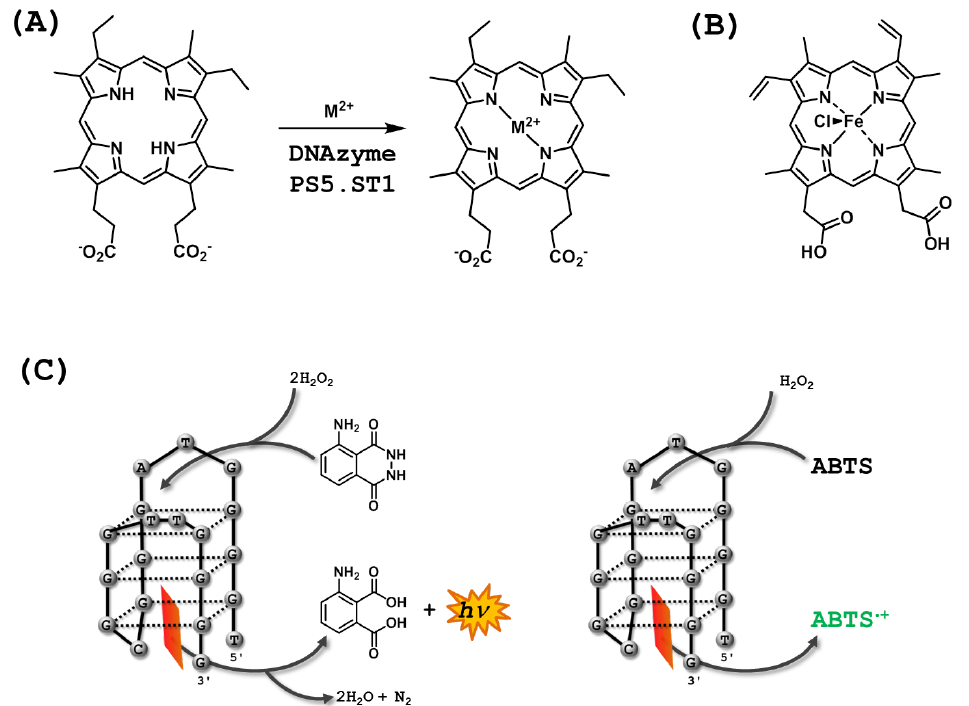
Figure 9. ( A ) Porphyrin metalation catalyzed by DNAzyme PS5.ST1 (M = Zn 2+ or Cu 2+ ) with ( A ) Porphyrin metalation catalyzed by DNAzyme PS5.ST1 (M = Zn 2+ or mesoporphyrin IX (MPIX) as a substrate [180]; ( B ) Chemical structure of the hemin (Fe(III)-protoporphyrin DNAzyme PS2.M with hemin: corresponding diacid and chemiluminescence [183,193]; oxidation of the chromogenic